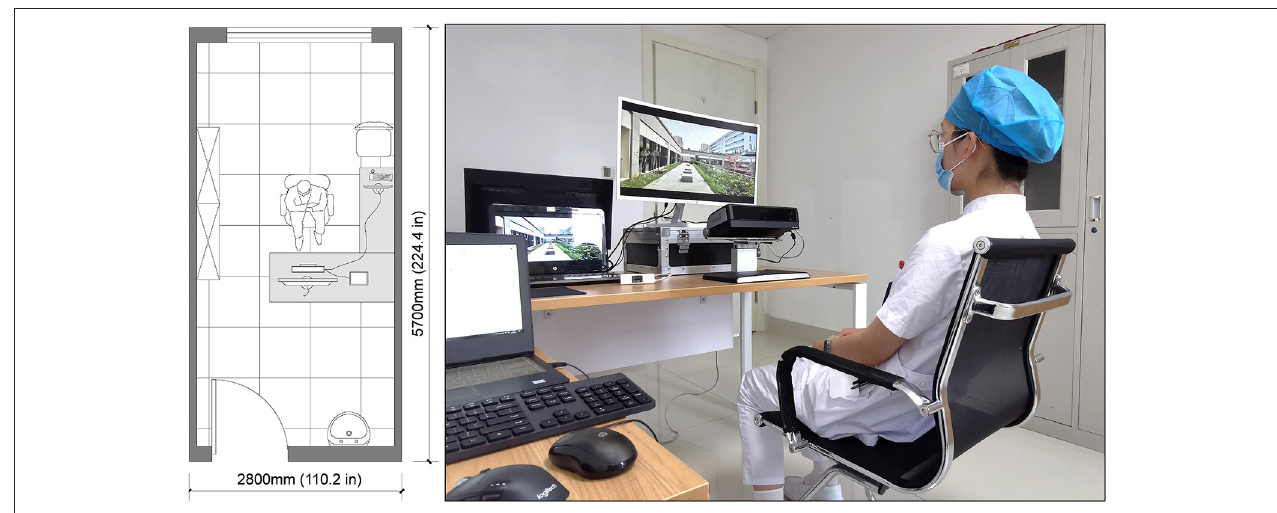
FIGURE 1 | The arrangement of experimental